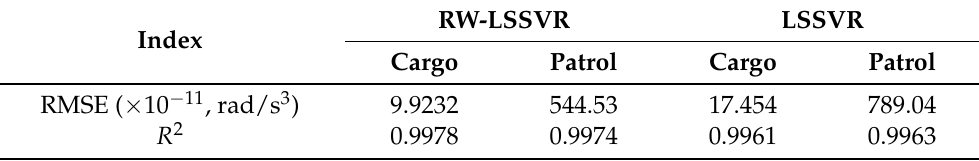
Figure 9. Prediction results of the patrol vessel. ( a ) Predicted and estimated Table 6. Prediction errors of the identified linear steering model for the two